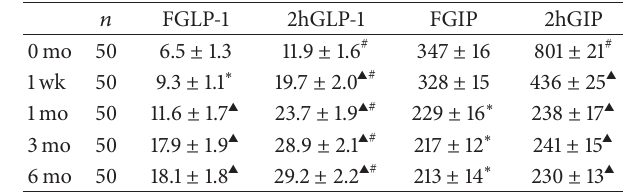
Table 2: Comparison of GLP-1 and GIP levels before and after the surgery.